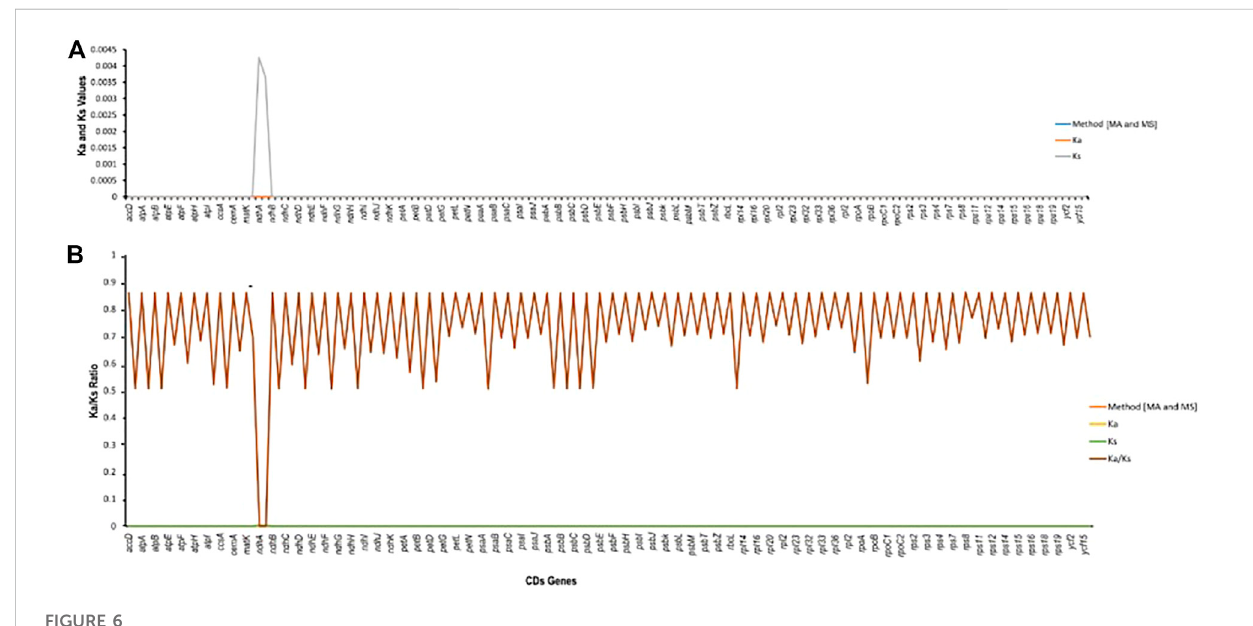
FIGURE 6 Estimation of CDS in Moringa oleifera and Moribga peregrina . (A) Ka/Ls values. (B) Ka/Ks